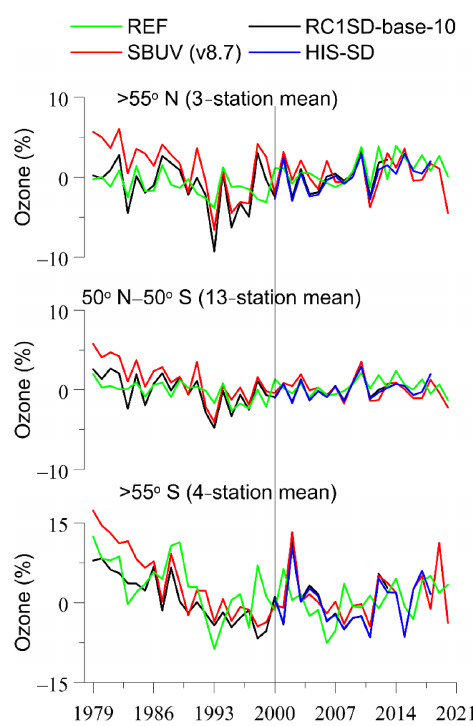
Figure A1. Comparison of REF (free-running simulation; green line) with RC1SD-base-10 (SD simulation for 1979–2013; black line), HIS-SD (SD simulation for 2000–2018; blue line), and SBUV (v8.7) satellite measurements (red line) for 3 stations higher than 55 ◦ N (upper plot), 13 stations between 50 ◦ N–50 ◦ S (middle plot), and 4 stations higher than 55 ◦ S (lower plot). The vertical line has been put in the year 2000. The y axis shows yearly averaged total-ozone data (in %) calculated from de-seasonalized monthly data. The monthly data were de-seasonalized relative to the long- term monthly mean (2000–2018) and were expressed in percent. For the northern high-latitude stations, the annual average refers to the average of monthly anomalies from March to September, and for the southern high-latitude stations, it refers to the average of monthly anomalies from September to March. For the stations be- tween 50 ◦ N–50 ◦ S we used all months to calculate the annual av-